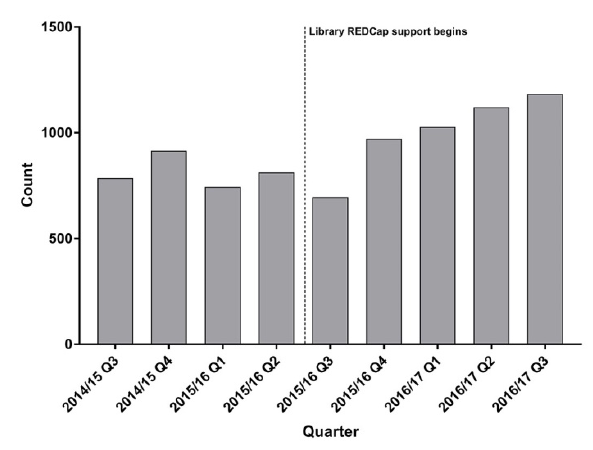
Figure 3 REDCap users by quarter